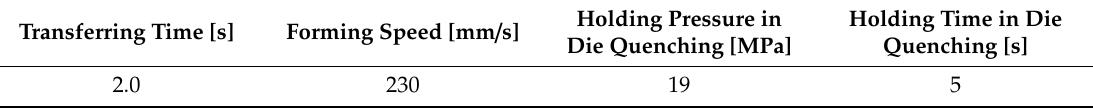
Table 1. Conditions used for hot stamping of hat-shaped